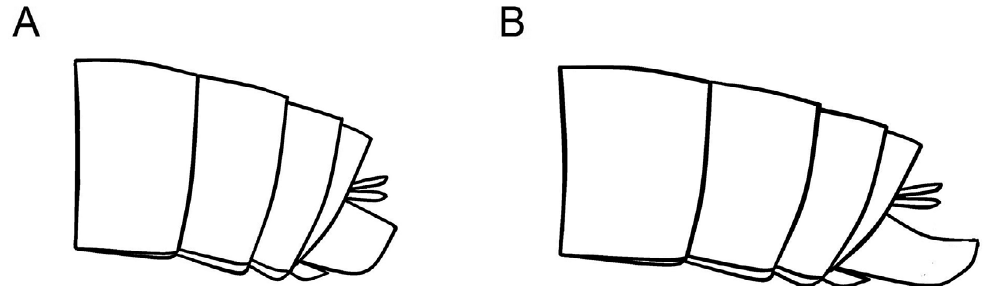
Fig. 7. Posterior metasomal segments and male parameres in lateral view. A . Enicospilus ryrholmi sp. nov., paratype, ♂ (MZLU Type no. 06123:10). B . E. cederbergi sp. nov., paratype, ♂ (NHRS-